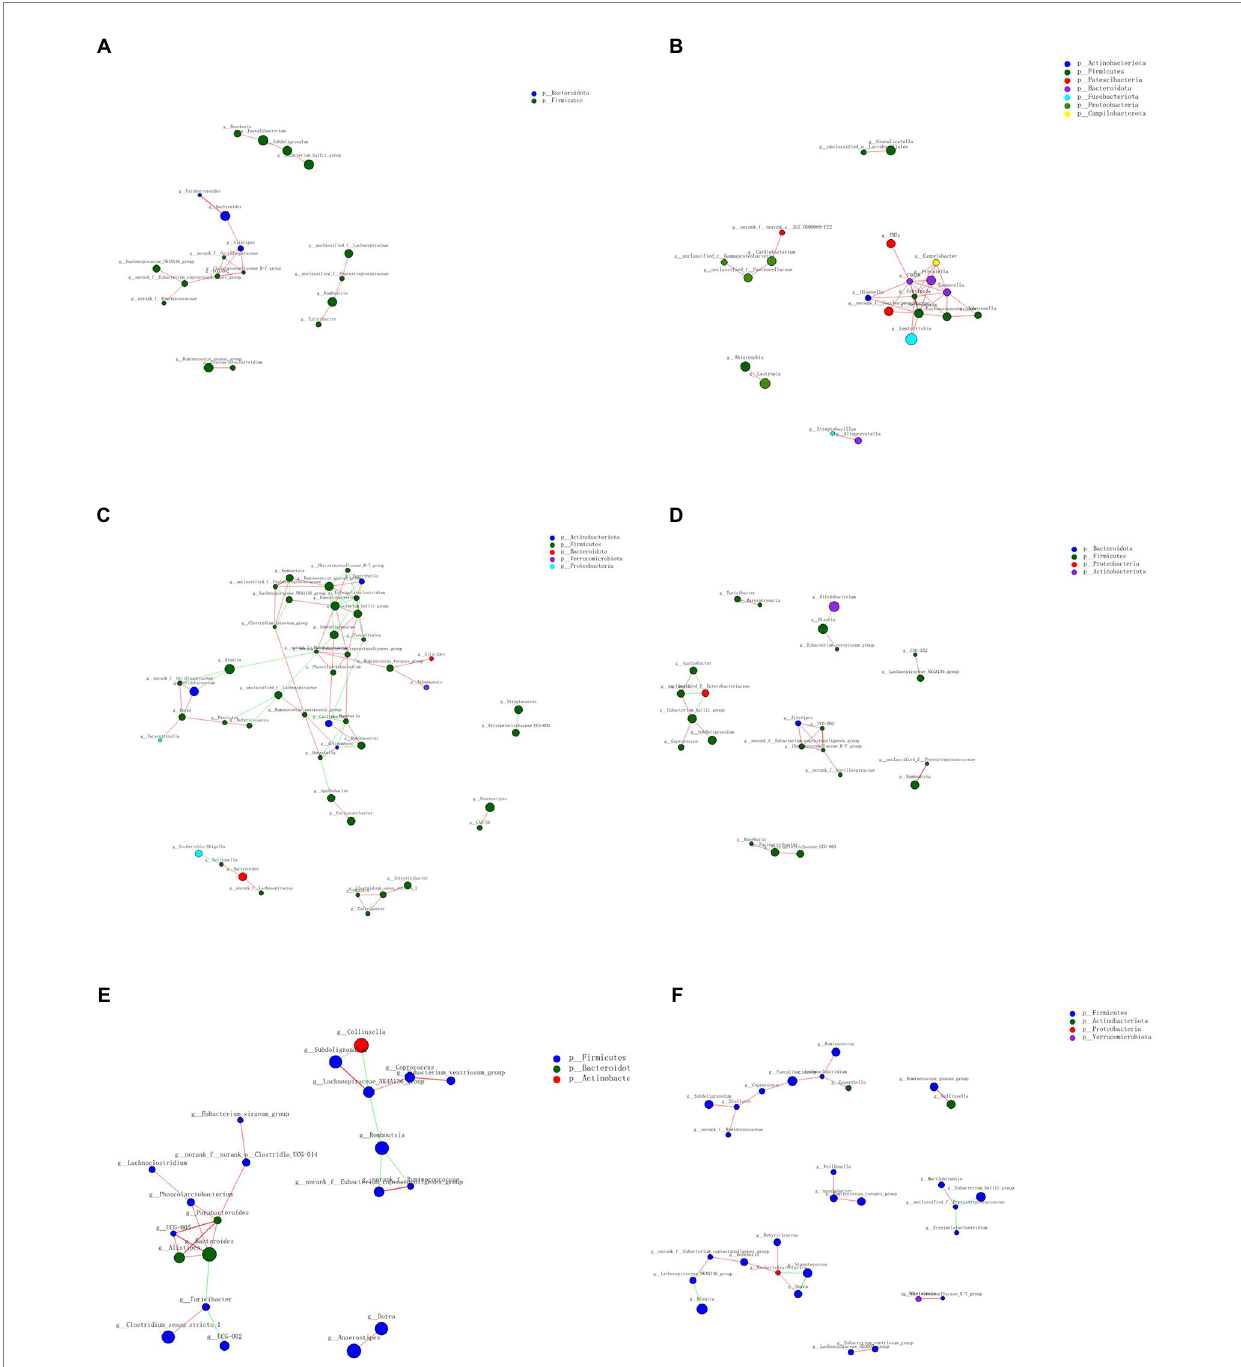
FIGURE 7 Network analysis showing interactions of the 50 richest genera (|Spearman coefficient| > 0.8, p < 0.01). Bacterial interactions in (A) all fecal samples, (B) all plaque samples, (C) BCF, (D) BF, (E) CF, and (F) F groups. The size of the node is proportional to the genera abundance. The node color corresponds to the phylum classification. The edge color represents positive (red) and negative (green)